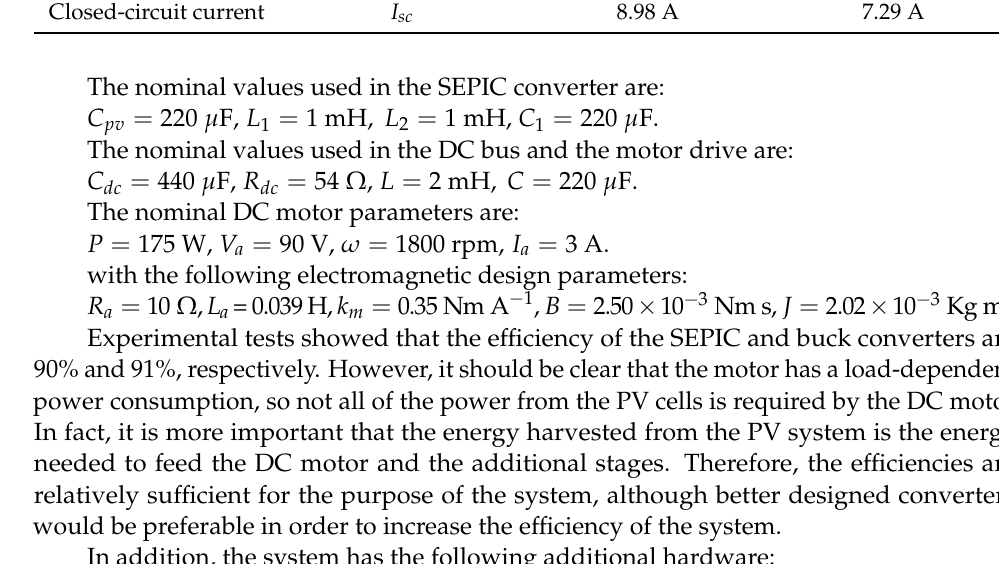
Table 3. Nominal values of the solar panel Eco Green Energy EGE-260P-60. Parameter Symbol STC NOCT Power P pv 260 W 192 W Voltage at maximum V mpp power point Current at maximum power